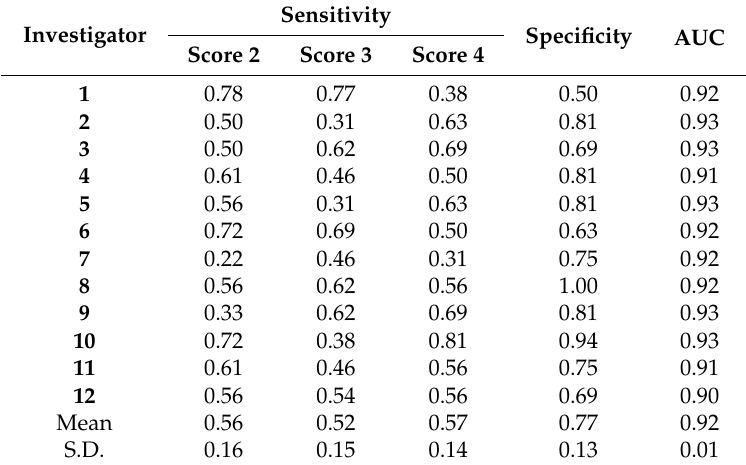
Table 2. Sensitivity (score 2, score 3, and score 4), specificity, and AUC values, obtained from digital dental radiograph.